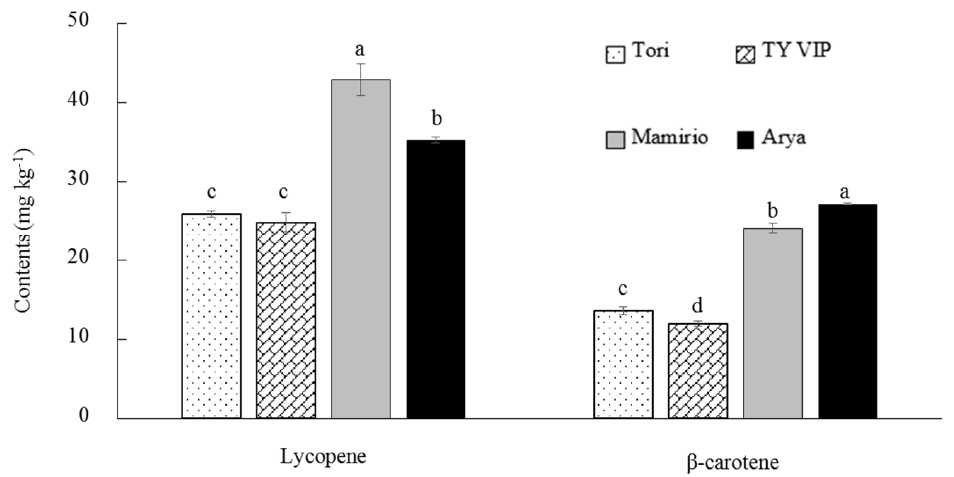
Figure 2. Lycopene and β -carotene contents of ‘Tori’, ‘TY VIP’, ‘Mamirio’, and ‘Arya’ tomato cultivars at the commercial pink ripening stage. The bars with different letters indicate a significant difference ( p < 0.05) between cultivars. The vertical bars represent the standard error of the means ( n = 5).